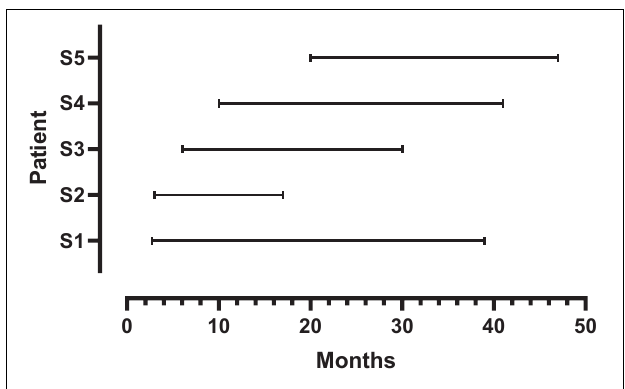
FIGURE 1 | Duration of CI listening experience at first and second test points for each patient. The beginning and endpoint of each line indicates the first and second test times, respectively.